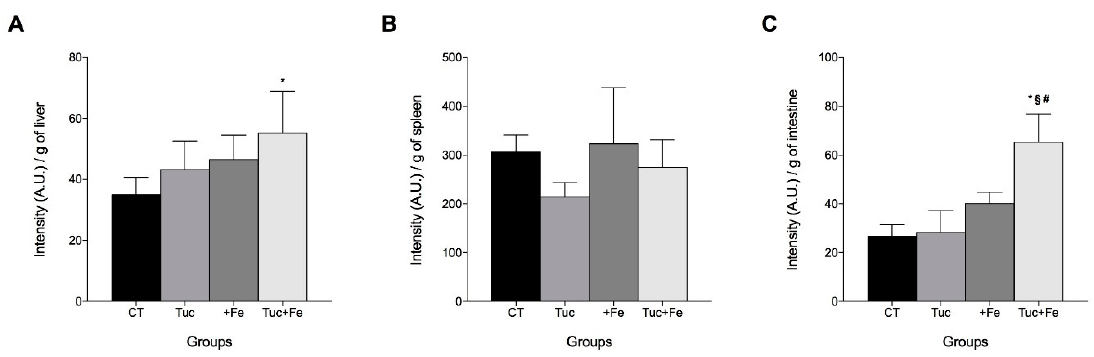
Figure 5. Labile iron pool levels of rats fed control diet, tucum-do-cerrado (Tuc), iron-enriched diet ( + Fe), or tucum-do-cerrado iron-enriched diet (Tuc + Fe), for 12 weeks, in: liver ( A ); spleen ( B ); and intestine ( C ). Data are the average ± standard deviation ( n = 6). Statistical differences compared to: * CT group; # Tuc group, and § + Fe group and ( p < 0.05).